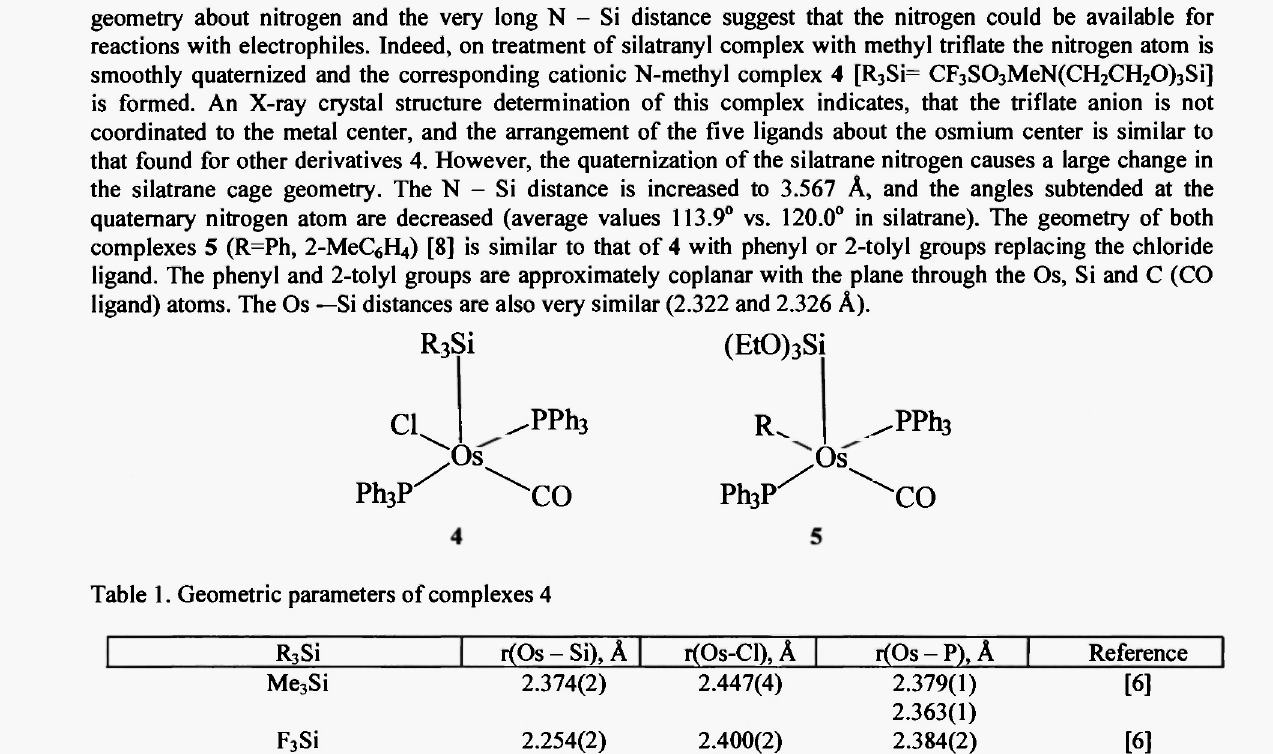
Table 1. Geometric parameters of complexes